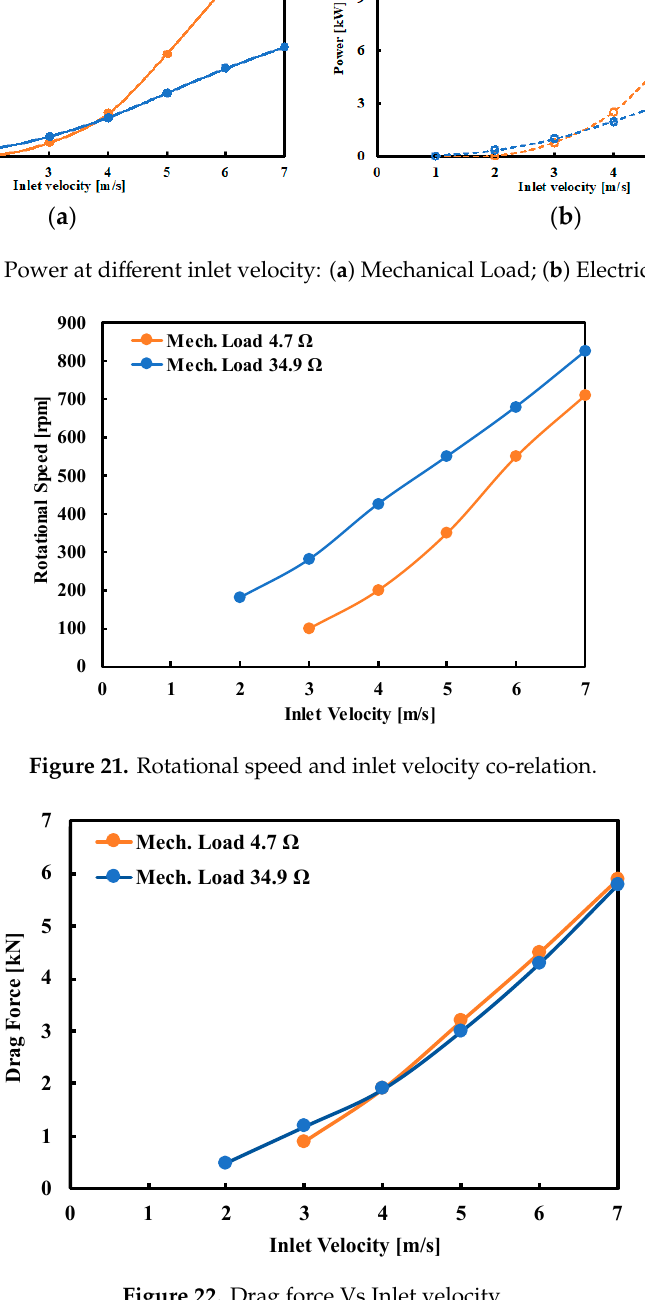
Figure 22. Drag force Vs Inlet velocity.